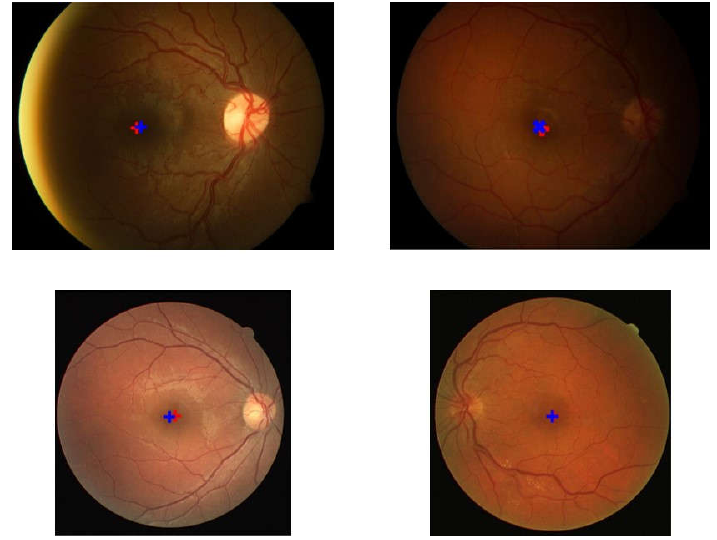
Figure 9. Examples of the detection results and location of the ground truth. The red ‘+’ symbol represents the detection result while the blue ‘+’ indicates the location of the ground truth.